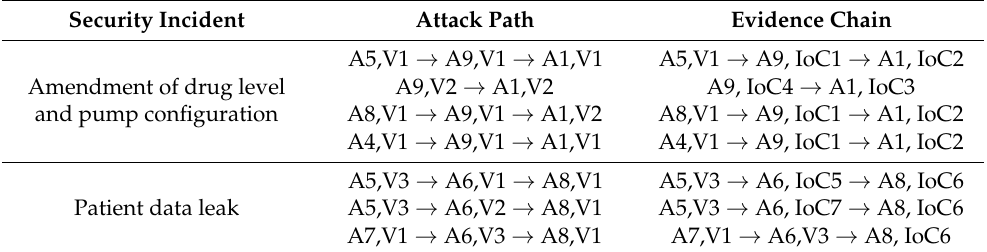
Table 6. Attack path based on confirmed security events and potential evidence